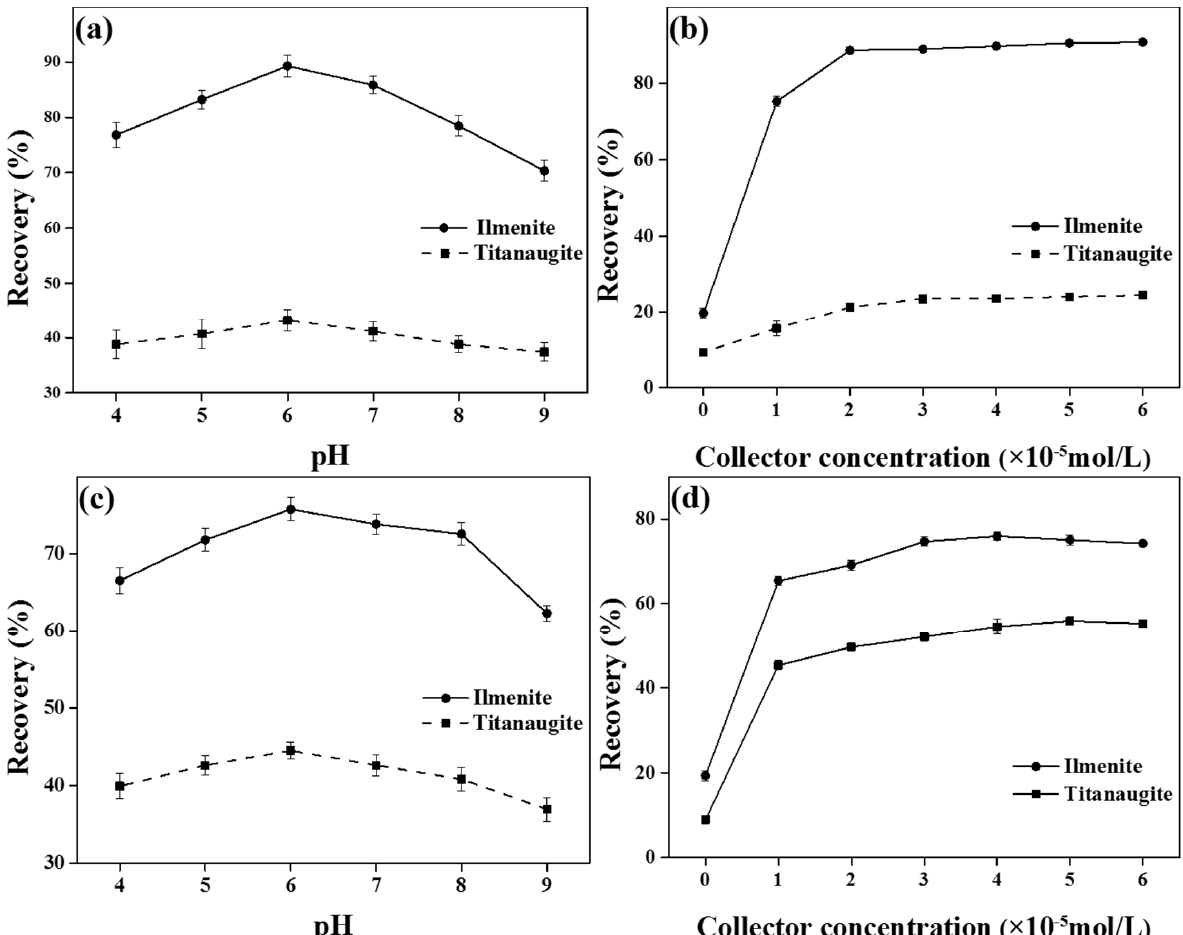
Figure 4. Recovery of ilmenite and titanaugite as a function of pH and collector dosage using APA as collector ( a , b ); recovery of ilmenite and titanaugite as a function of pH and collector dosage using OPA as collector ( c , d